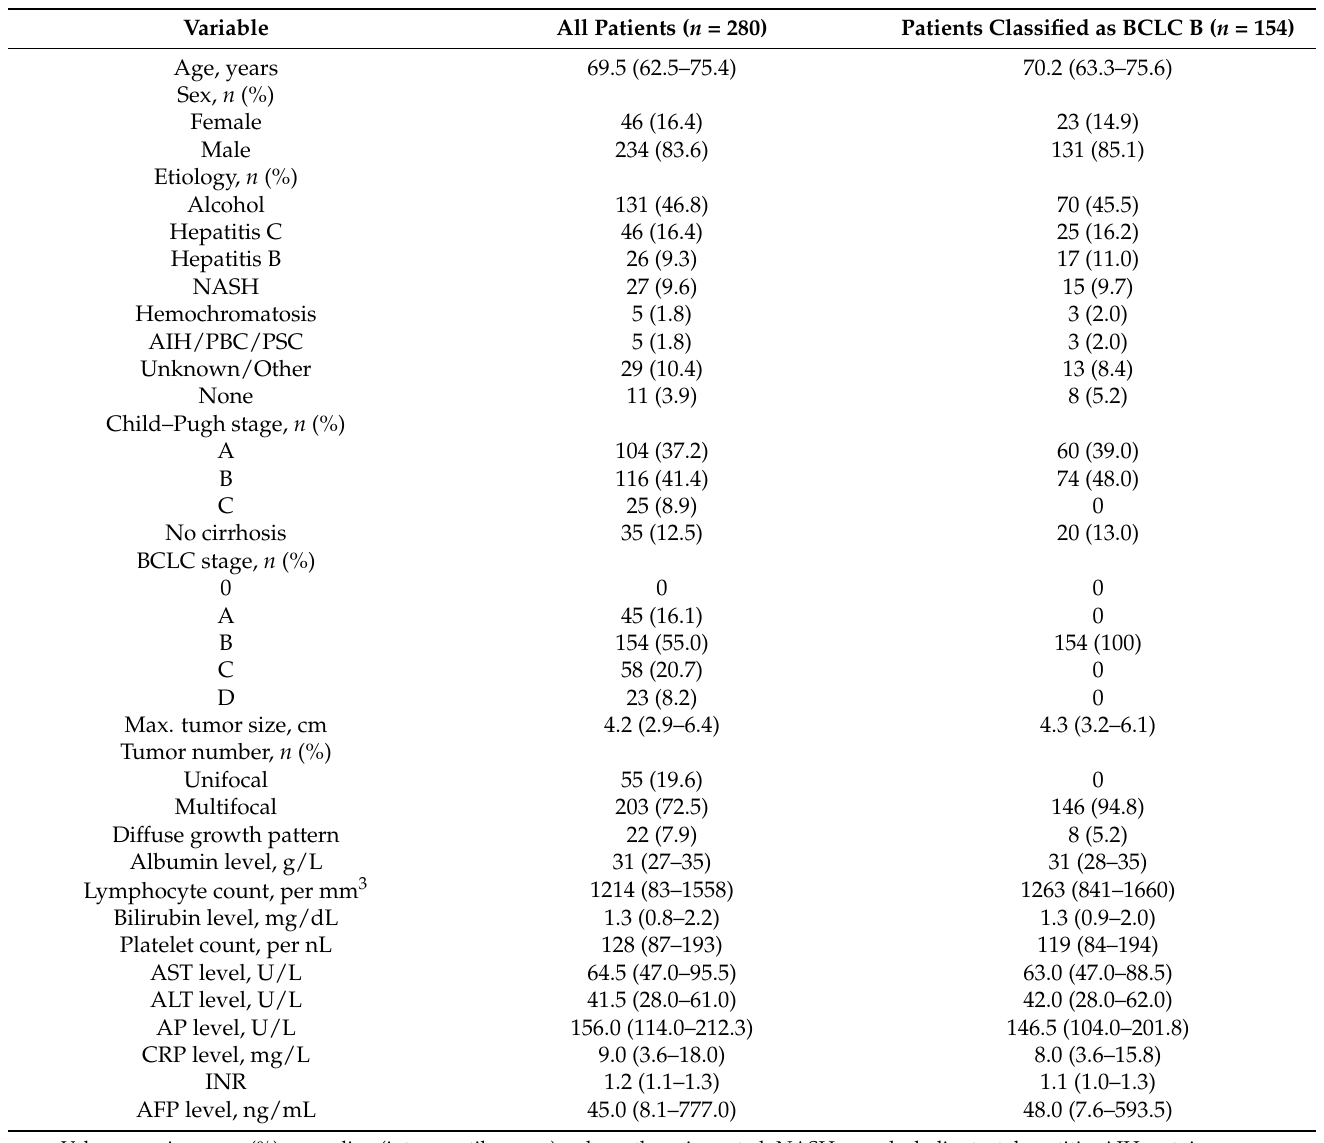
Table 1. Baseline characteristics of patients with HCC undergoing TACE included in this study.